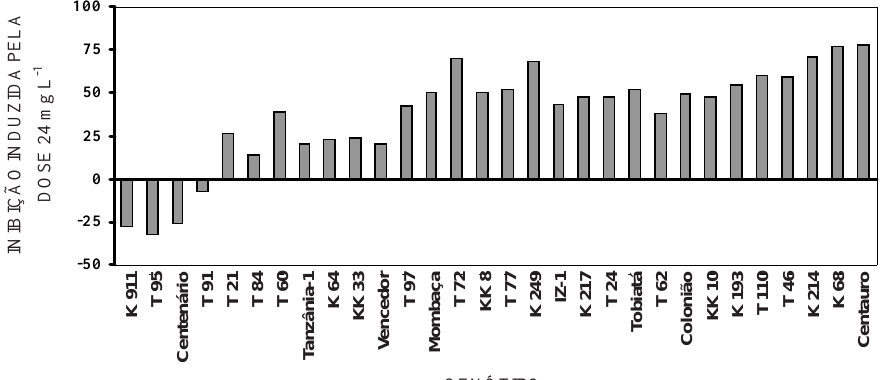
Figura 3. Inibição do alongamento radicular de 30 genótipos de Panicum maximum induzida por 24 mg L -1 de Al em solução